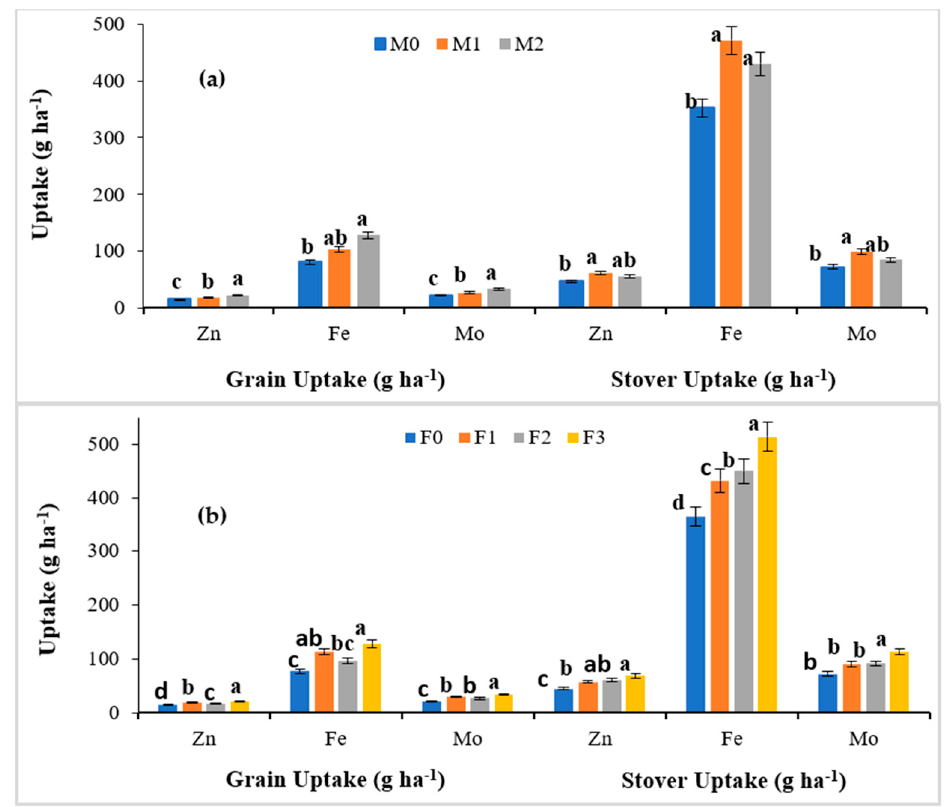
Figure 3. ( a ) Effect of different methods of Mo and ( b ) Fe and Zn application on Zn, Fe and Mo uptake in the grain and stover of cowpea. The column representing the mean with a similar or dissimilar letter(s) was evaluated with the least significant difference (LSD) multiple range tests using a probability level of p ≤ 0.05 along with standard deviation.